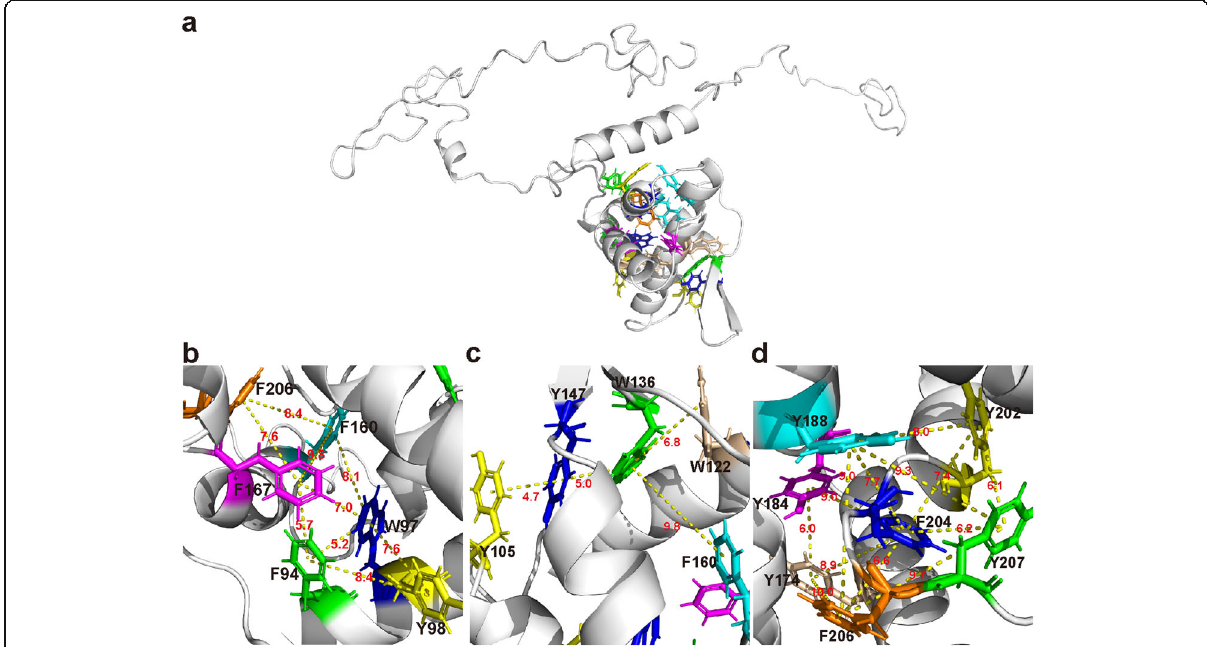
Fig. 1 π -stacking analysis based on the predicted TVBMV CP 3D model. a The overview of the predicted TVBMV CP 3D cartoon model. Sixteen aromatic residues forming π -stackings are indicated in sticks. b – d The close view of the π -stackings between 16 aromatic residues in TVBMV CP. The positions of F 94 , W 97 , Y 98 , F 160 , F 167 and F 206 indicated with different colors are shown in b . The positions of Y 105 , W 122 , W 136 , Y 147 and F 160 indicated with different colors are shown in c . The positions of Y 174 , Y 184 , Y 188 , Y 202 , F 204 , F 206 and Y 207 indicated with different colors are shown in d . The centroid distance less than 10 Å between two aromatic rings is indicated with a yellow dash line and the corresponding distance values are indicated with red